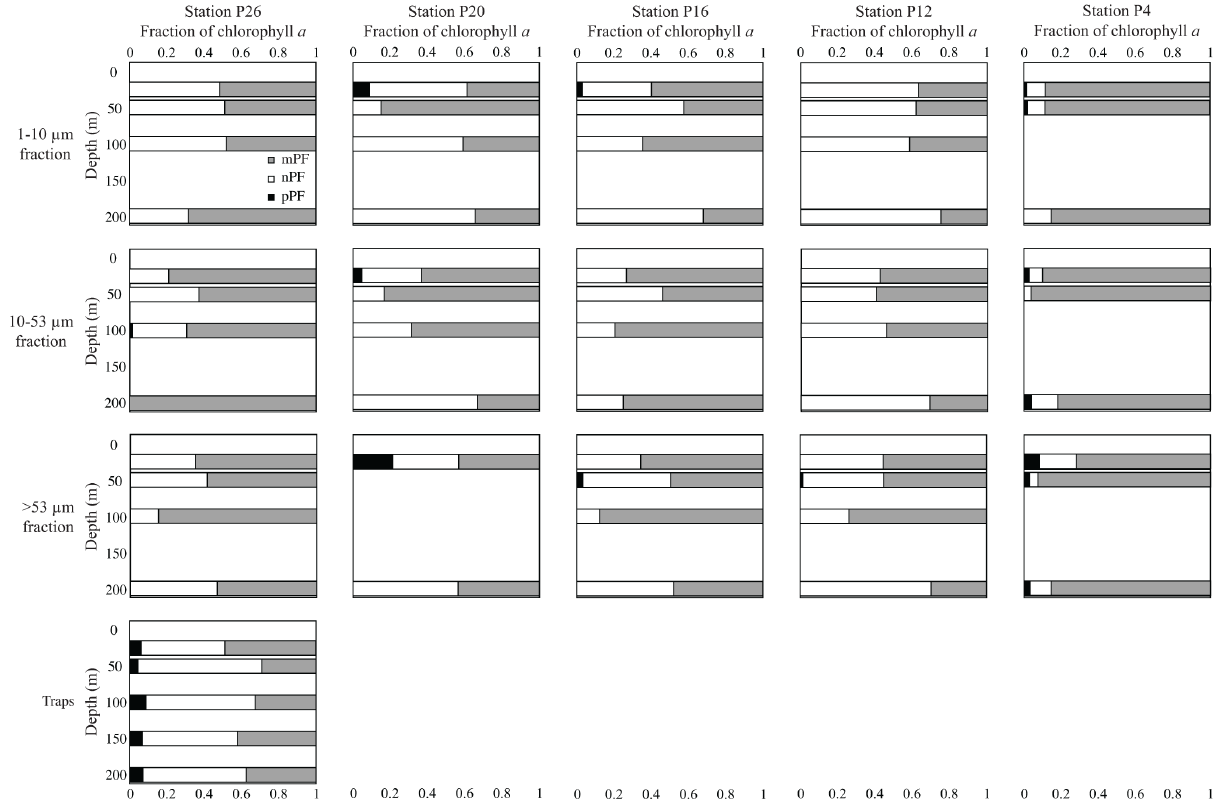
Figure 8. Pigment PFs for each phytoplankton size class plotted as a function of sample depth and particle size class at stations sampled on Line P in June 2012. Size-fractionated data are pump data. Sediment trap PFs are also included where